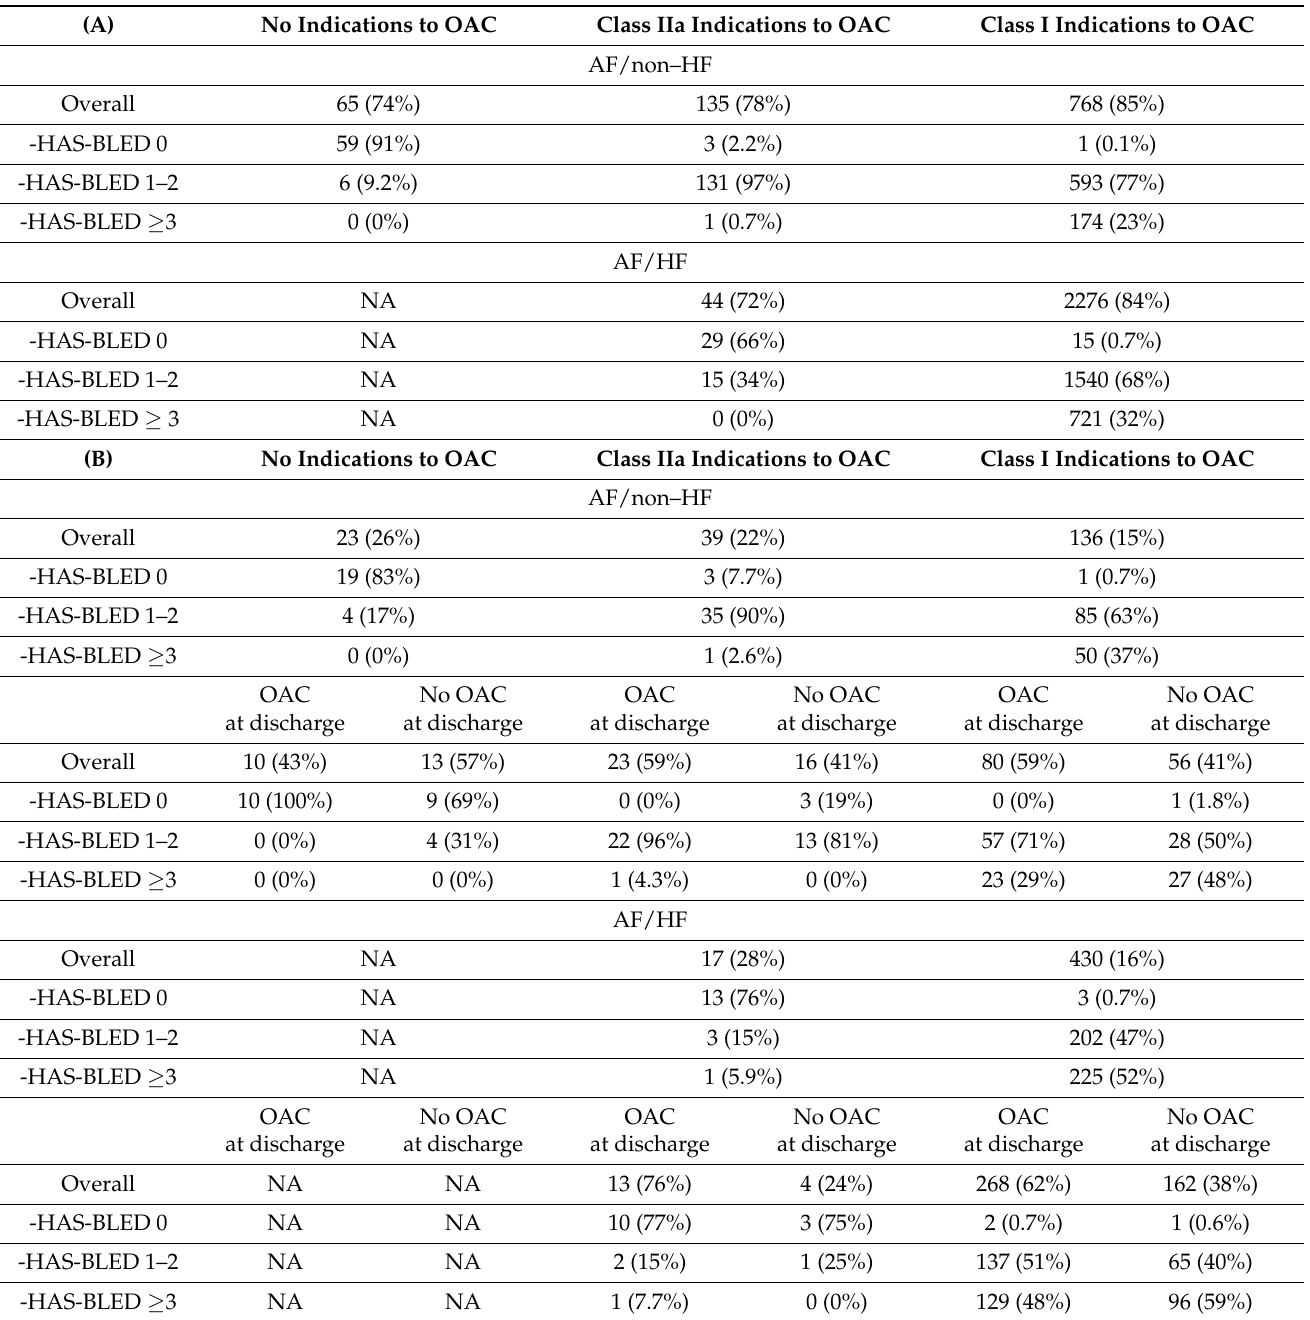
Table 3. ( A ) Proportion of patients receiving oral anticoagulation at hospital admission in relation to heart failure presence and indications to oral anticoagulation [2]. ( B ) Proportion of patients not receiving oral anticoagulants at hospital admission who received oral anticoagulation at discharge in relation to heart failure presence and indications to oral anticoagulation